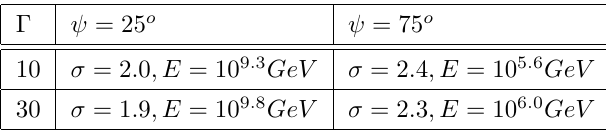
Table 1: Examples of simulations for single shocks with different shock Lorentz factors (Γ) and shock in- clination angles ( ψ ), and the attained spectral indices ( σ ), and maximal particle energies E ,